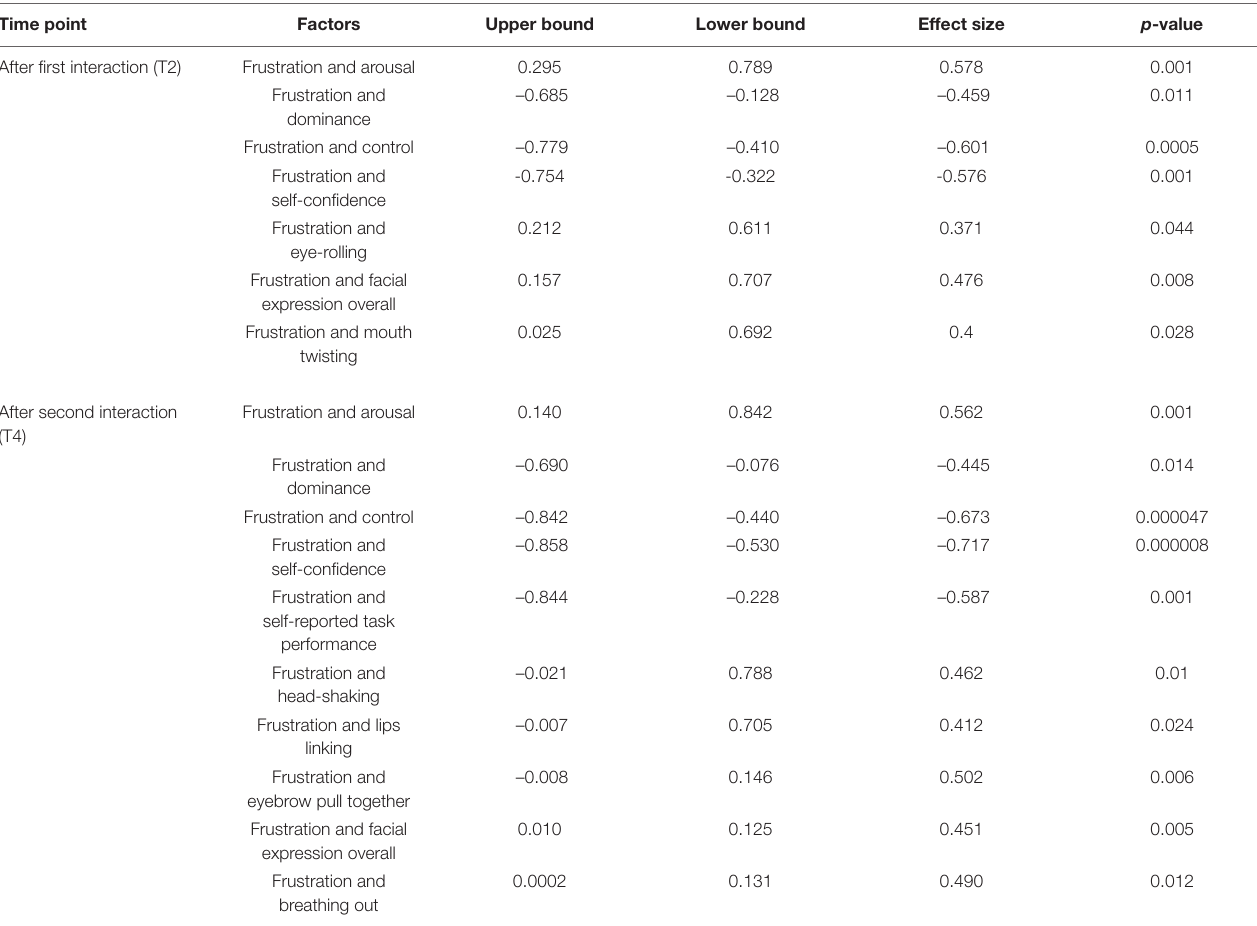
TABLE 3B | The table shows the correlation between frustration and interaction factors (see also section “Frustration correlated negative with dominance, control and self-confidence”).